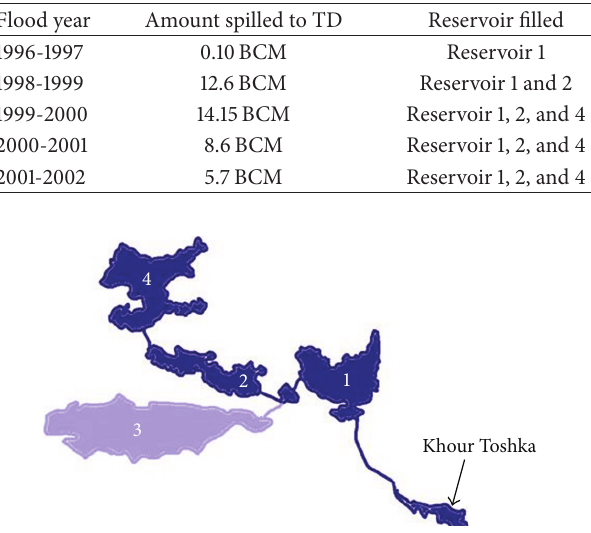
Figure 1: Toshka depression four subdepressions.